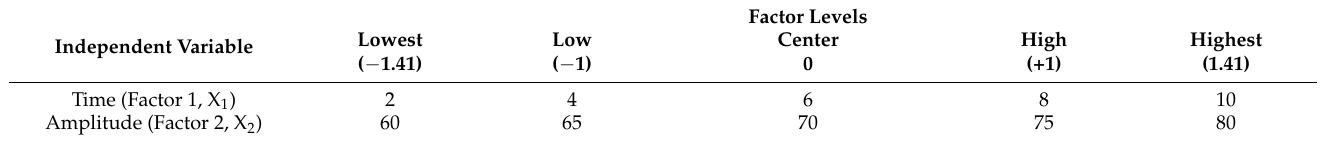
Table 1. Independent variables and their levels in